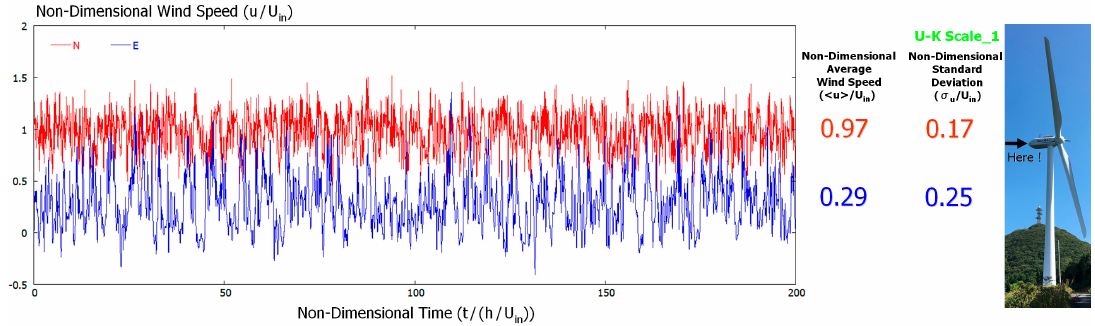
Figure 21. Time-series data of streamwise wind velocity from the numerical simulations. Red: northerly wind, Blue: easterly wind.